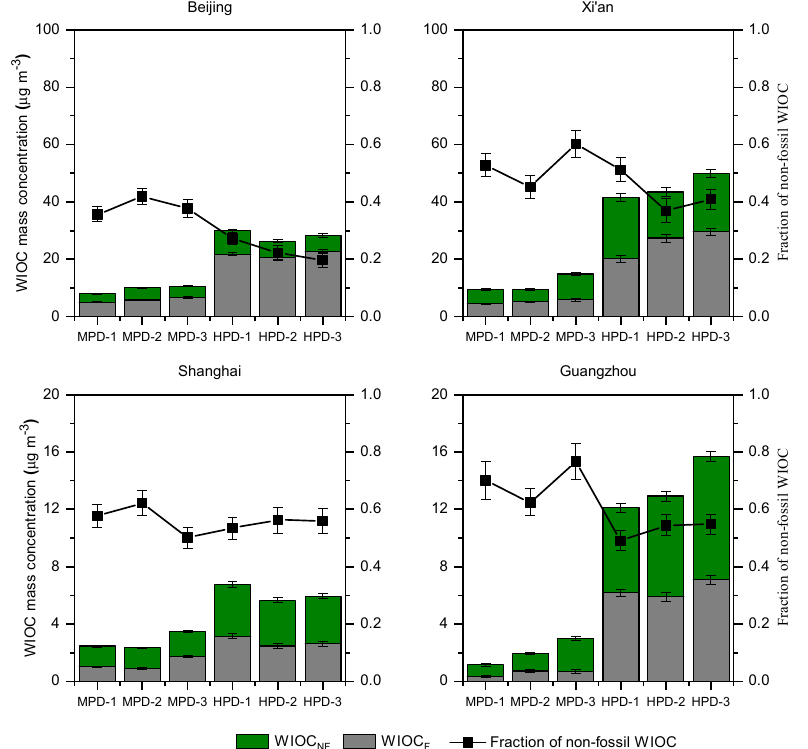
Figure 5. Mass concentrations (µgm − 3 ) of WIOC from non-fossil and fossil fuel sources (WIOC NF and WIOC F , respectively) as well as non-fossil fractions in the WIOC aerosols from Beijing, Xi’an, Shanghai and Guangzhou during moderately polluted days (MPD) and heavily polluted days (HPD). Note the different scaling for different cities.